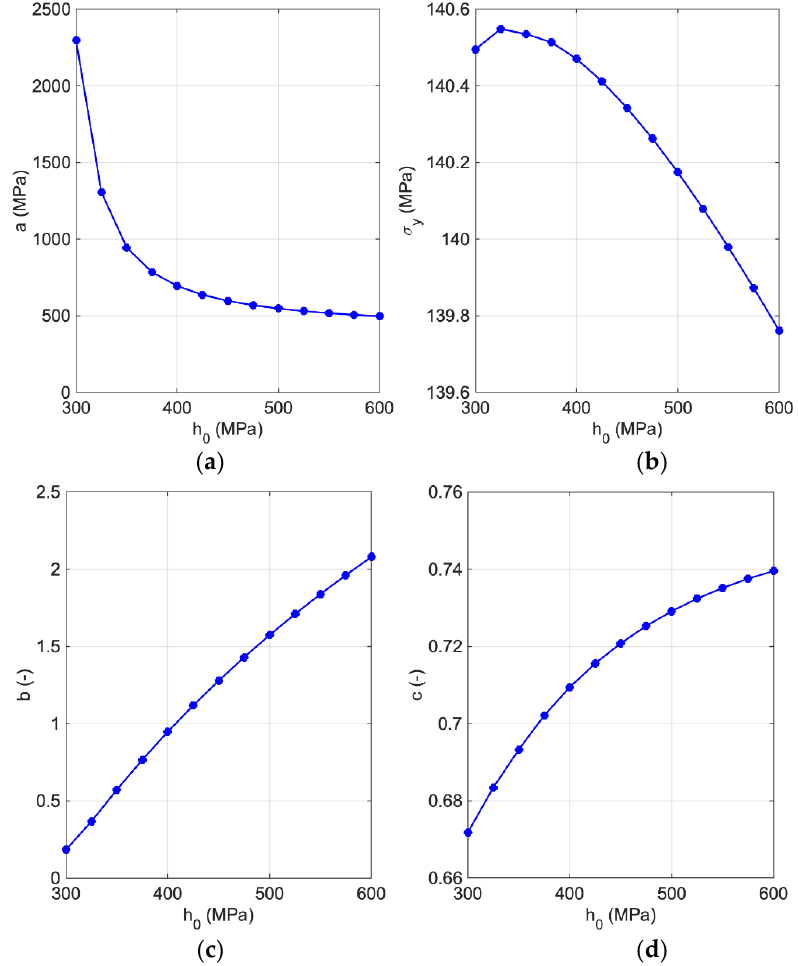
Figure 8. Variation of hardening parameters with change in h 0 , ( a ) a , ( b ) σ y , ( c ) b and ( d ) c .